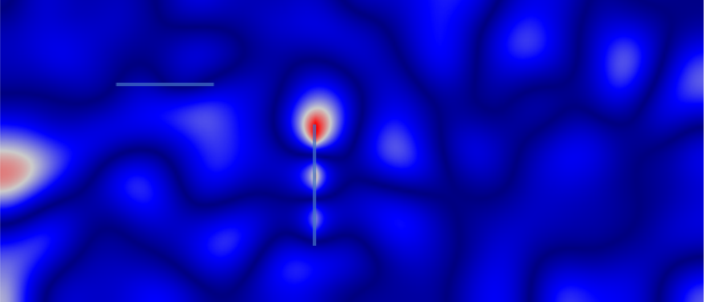
Figure 10. The absolute pressure on the whole domain at time 1.212ms. Beams are plotted with light blue color. Pressure activity is evident at the top of the vertical beam.